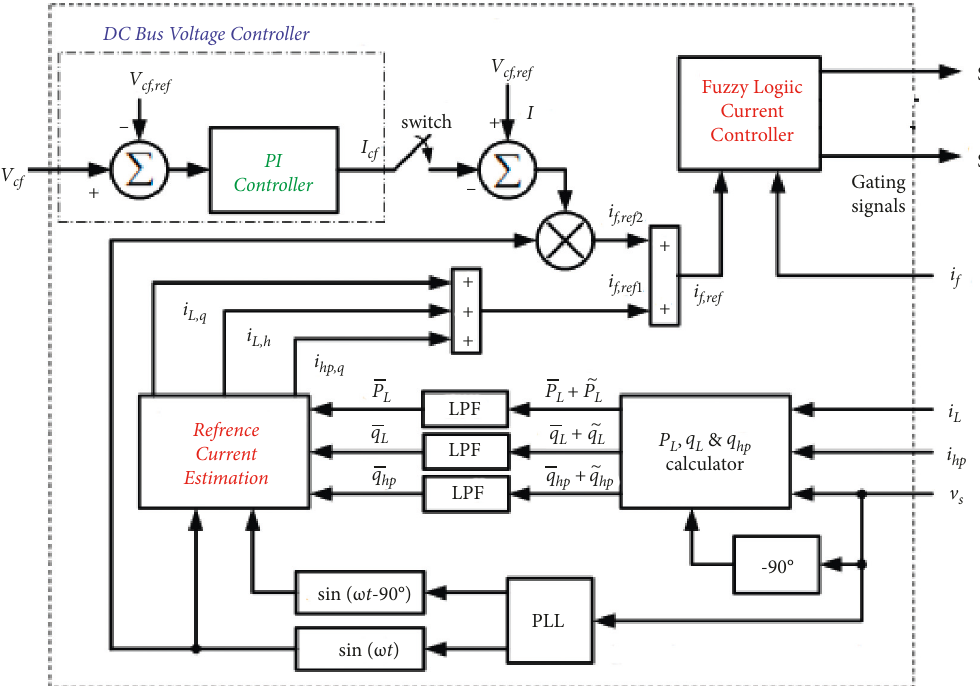
Figure 15: Proposed single-phase half-bridge HAPF based on FLCC with Reference current estimators (RCE) and PI controller for DC